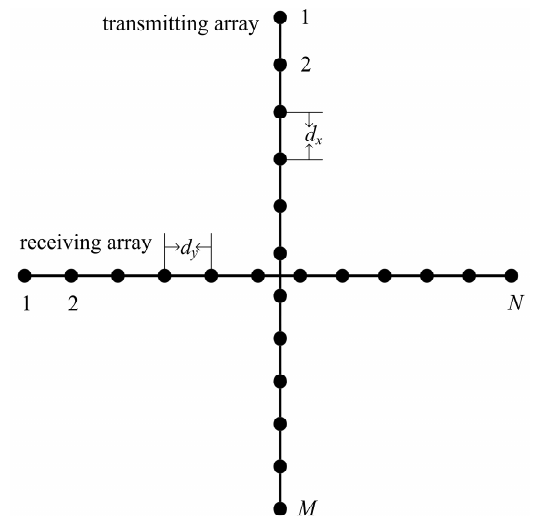
Figure 1. Configuration of the cross array.